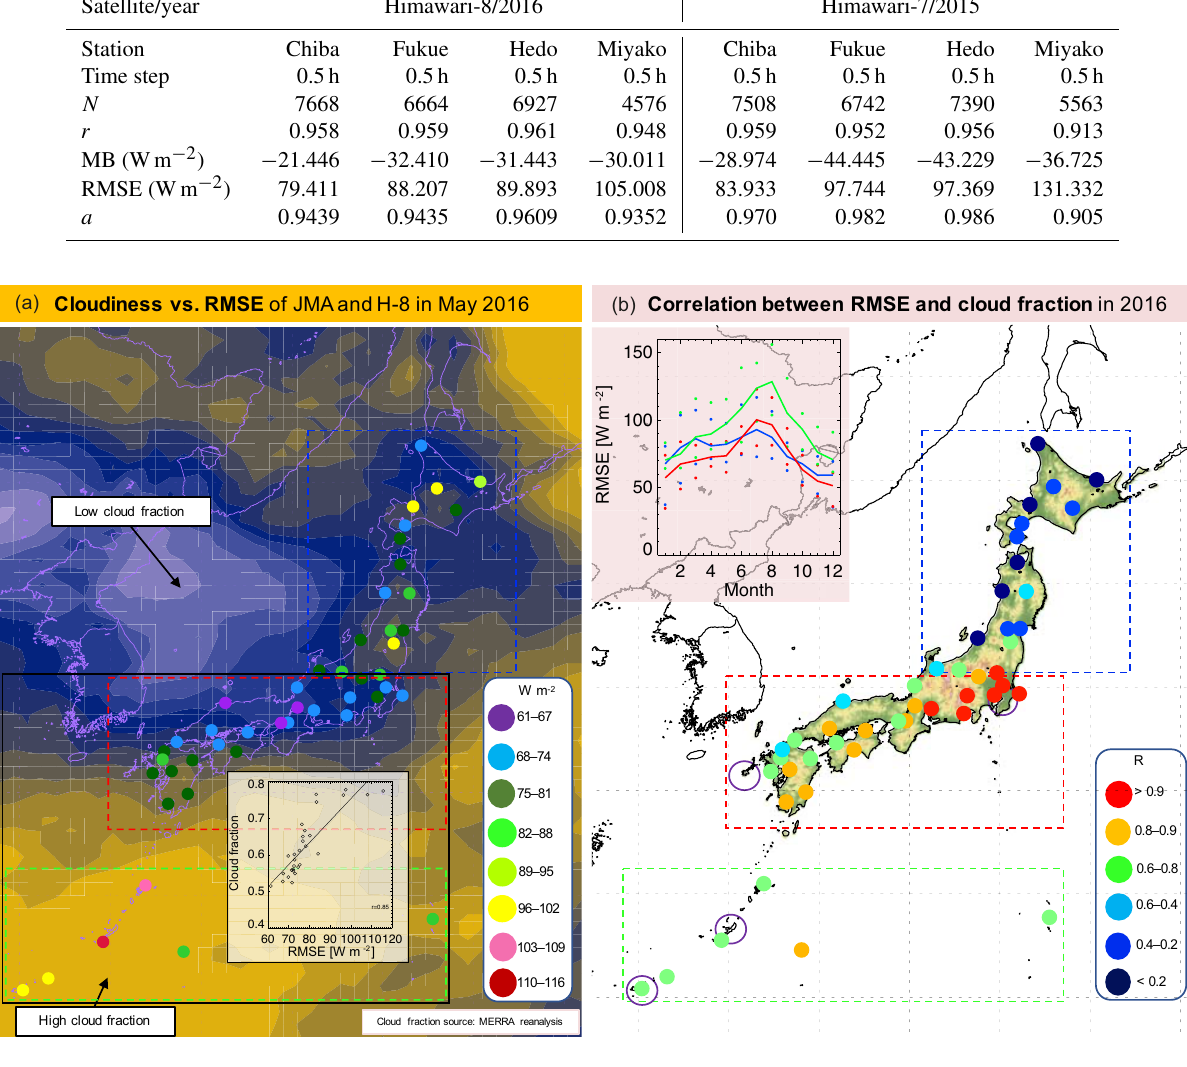
derived from GTOPO-30